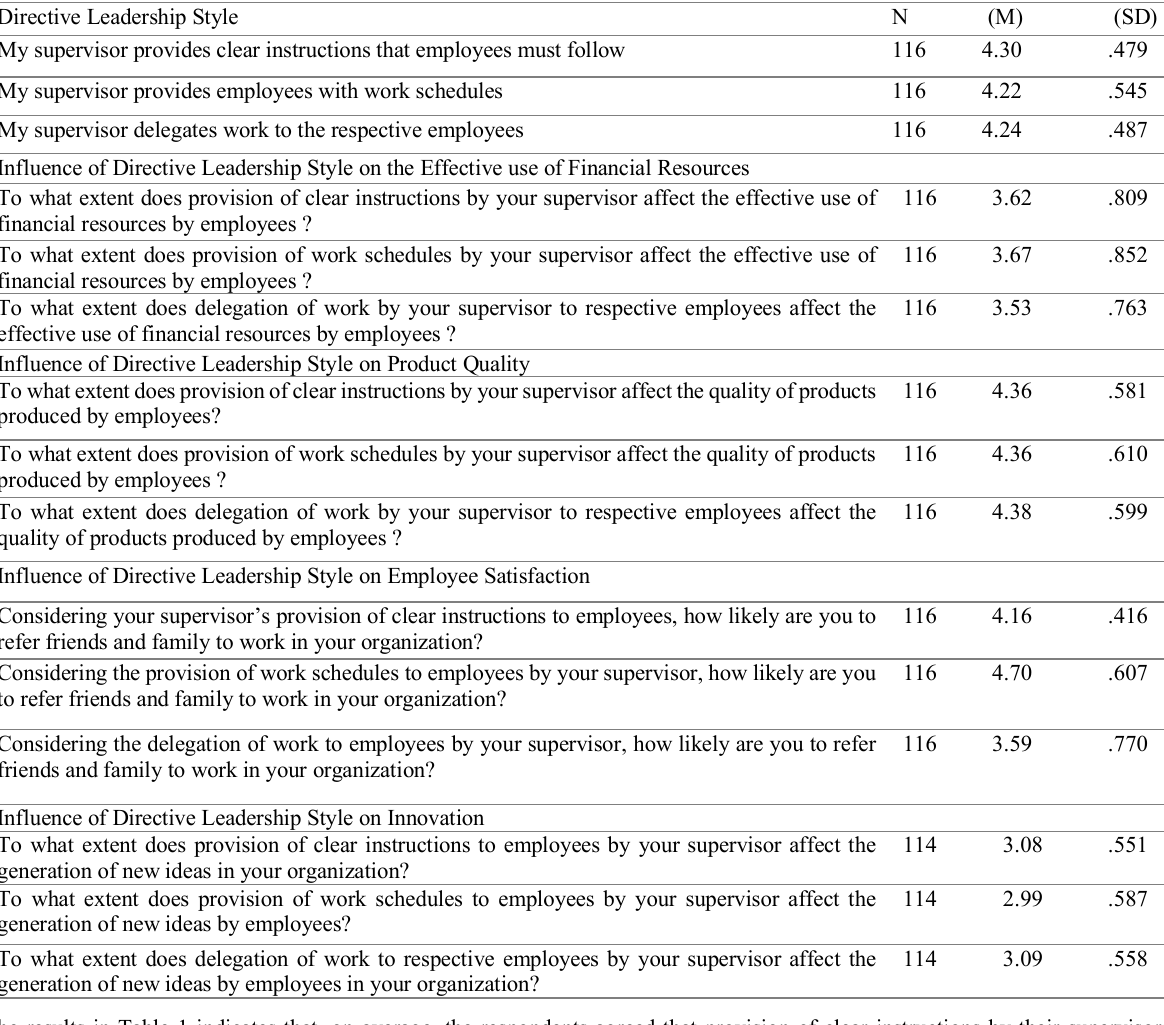
Table 1: Mean (M) and Standard Deviation (S.D) for Directive Leadership